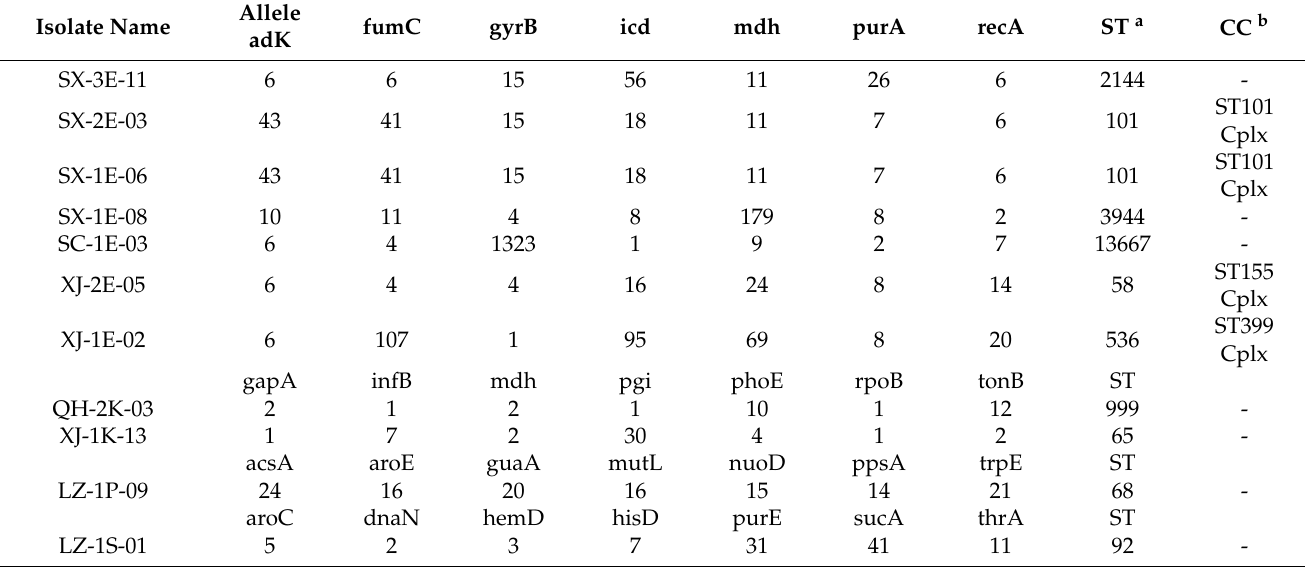
Table 4. ST and allele of tigecycline-resistant